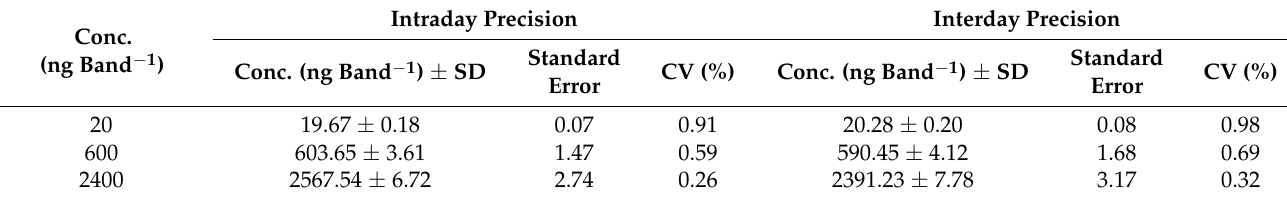
The results of the robustness analysis for the present analytical method are shown in Table 5. The % CVs for the robustness analysis were predicted as 0.59–0.66% for the present analytical method. The R f values of HDQ were found in the 0.82–0.84 range for the present analytical method. The narrow changes in the R f values of HDQ and lower % CVs showed the robustness of the present analytical method for HDQ quantification in